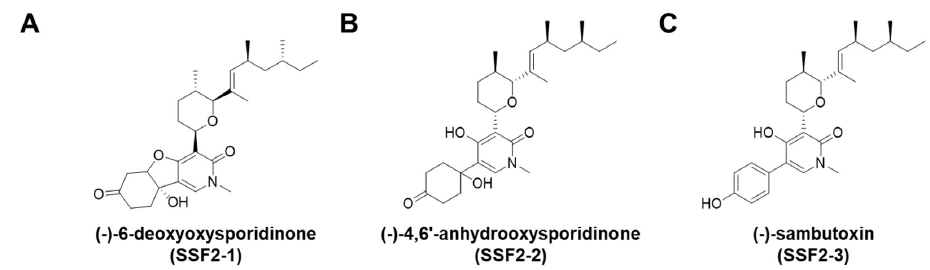
Figure 1. Structures of (A) SSF2-1, (B) SSF2-2, and (C) SSF2-3 isolated from cultures of Fusarium lateritium SSF2.